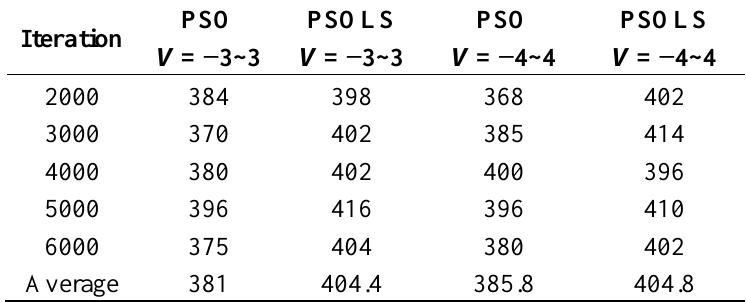
Table 3. Performance comparison among PSO and PSOLS ( c